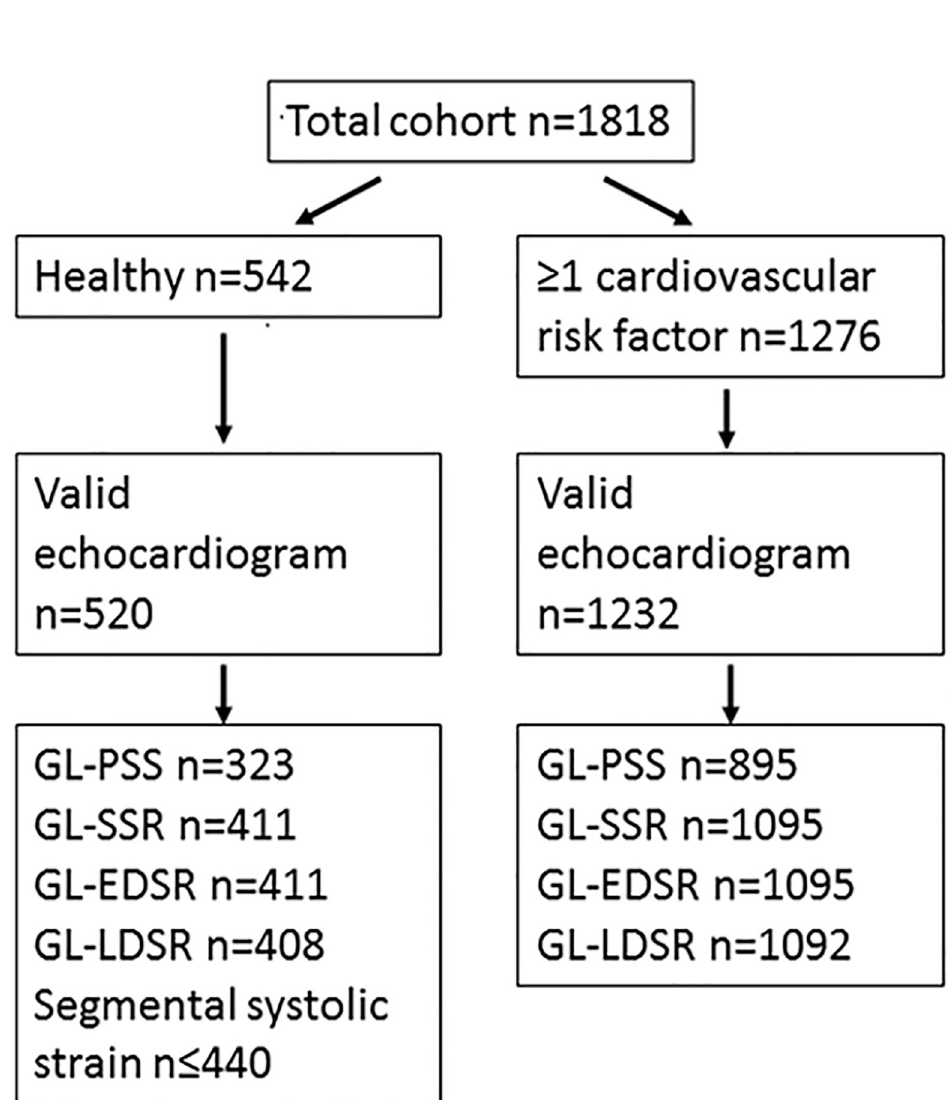
Fig 1. Number of individuals in each sub-sample in whom strain parameters could be derived. GL-PSS = global longitudinal peak systolic strain, GL-SSR = global longitudinal systolic strain rate, GL-EDSR = global longitudinal early diastolic strain rate, and GL-LDSR = global longitudinal late diastolic strain rate.